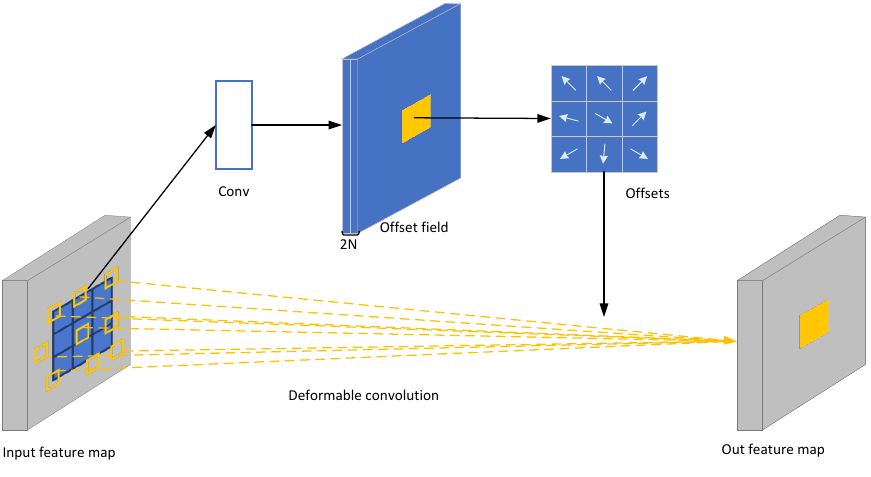
Figure 5. Deformable convolution process.